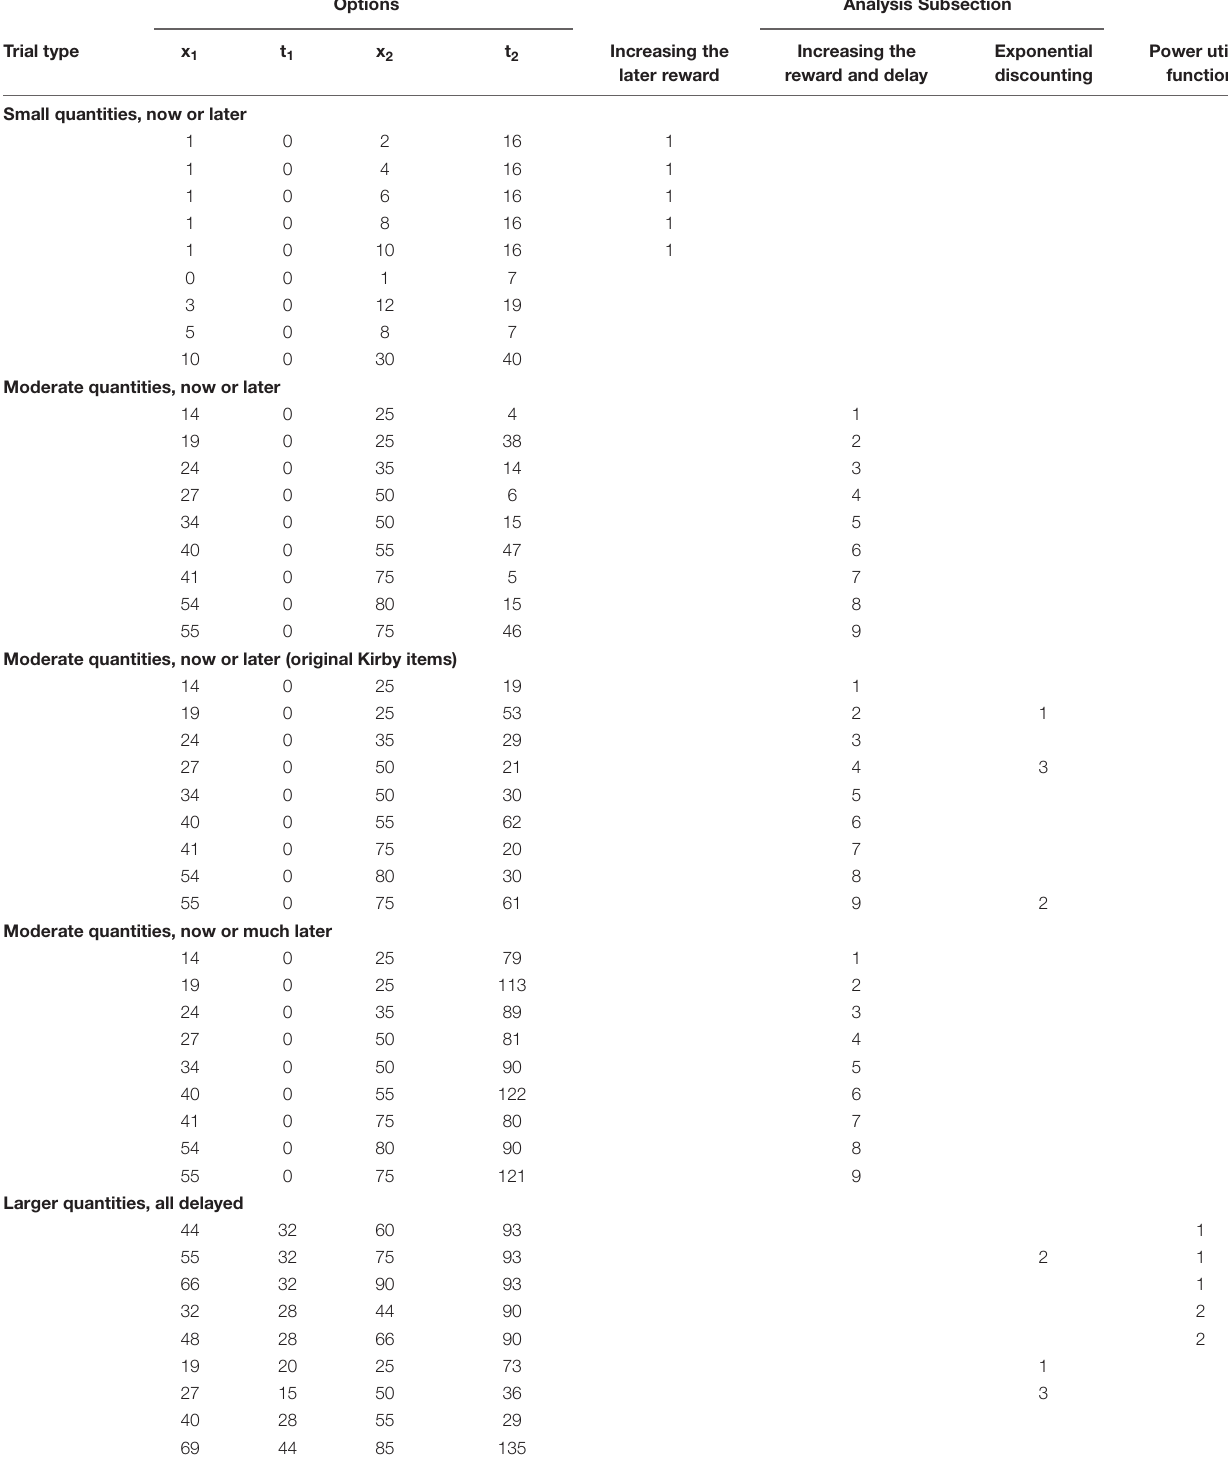
TABLE 1 | Trials in the Intertemporal Discounting Task (ITD), sorted by trial type.